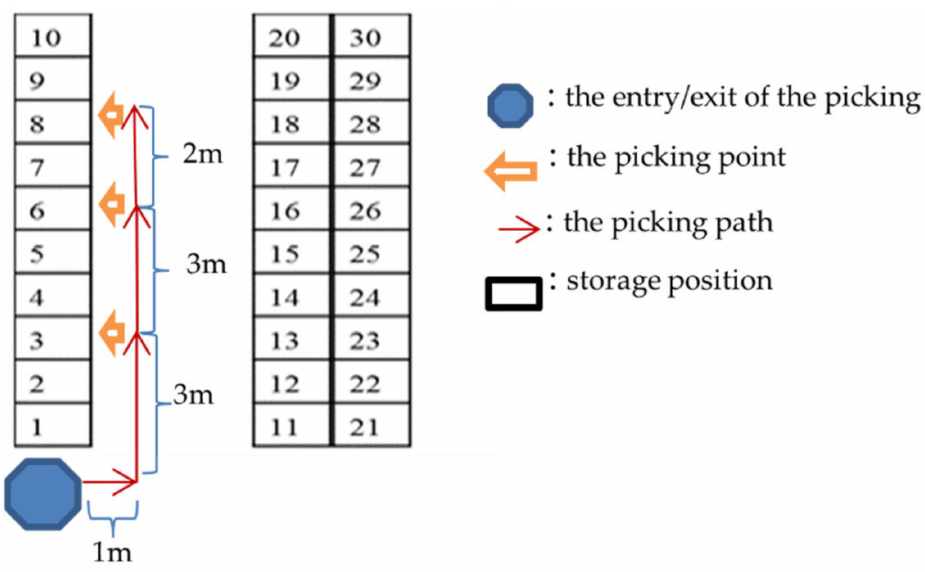
Figure 1. Calculation Representation of the Distance.